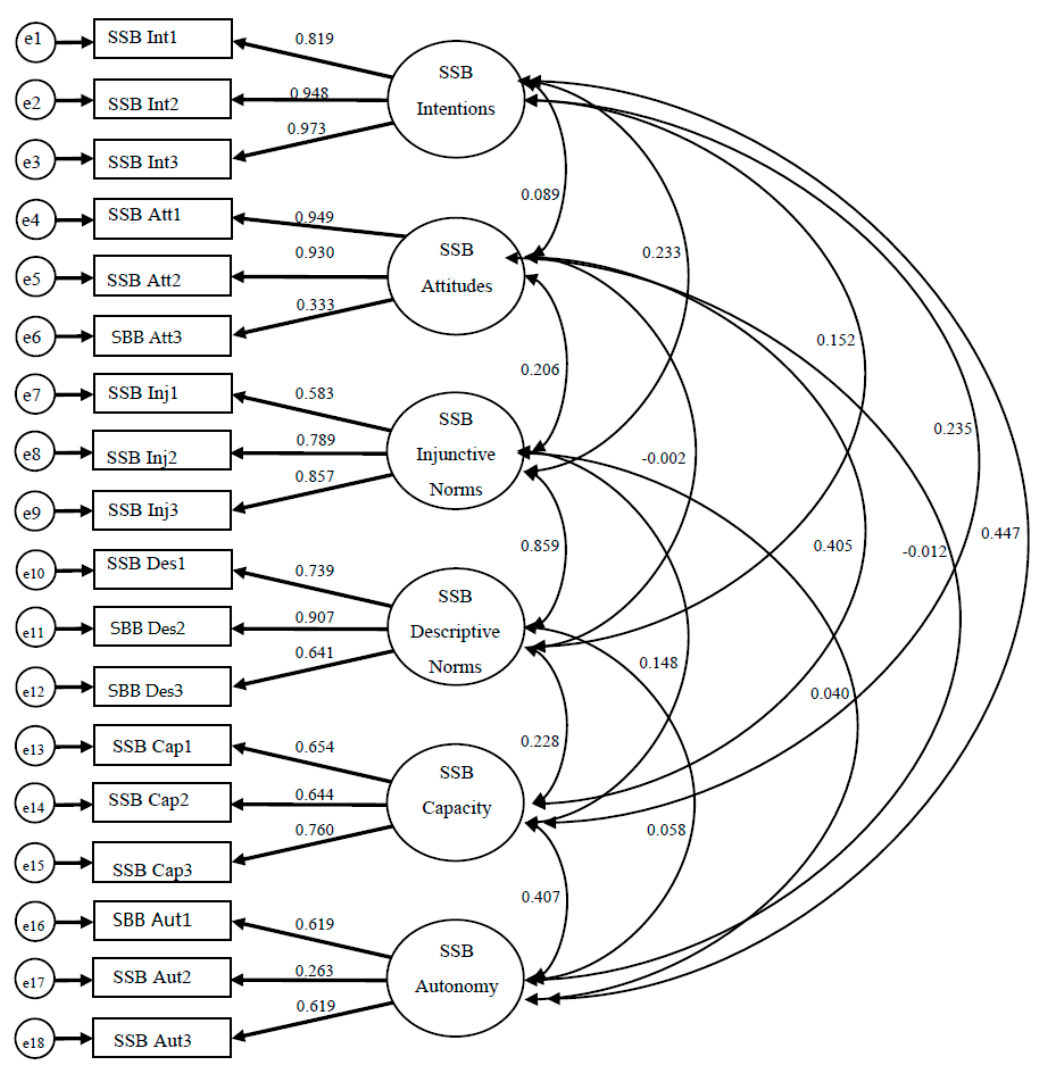
Figure 2. Results from confirmatory factor analysis (CFA) analyses for the sugar-sweetened beverage monitoring instrument (Comparative Fit Index (CFI) = 0.94, Tucker–Lewis Index (TLI) = 0.924, and Root Mean Square Error of Approximation (RMSEA) = 0.066).